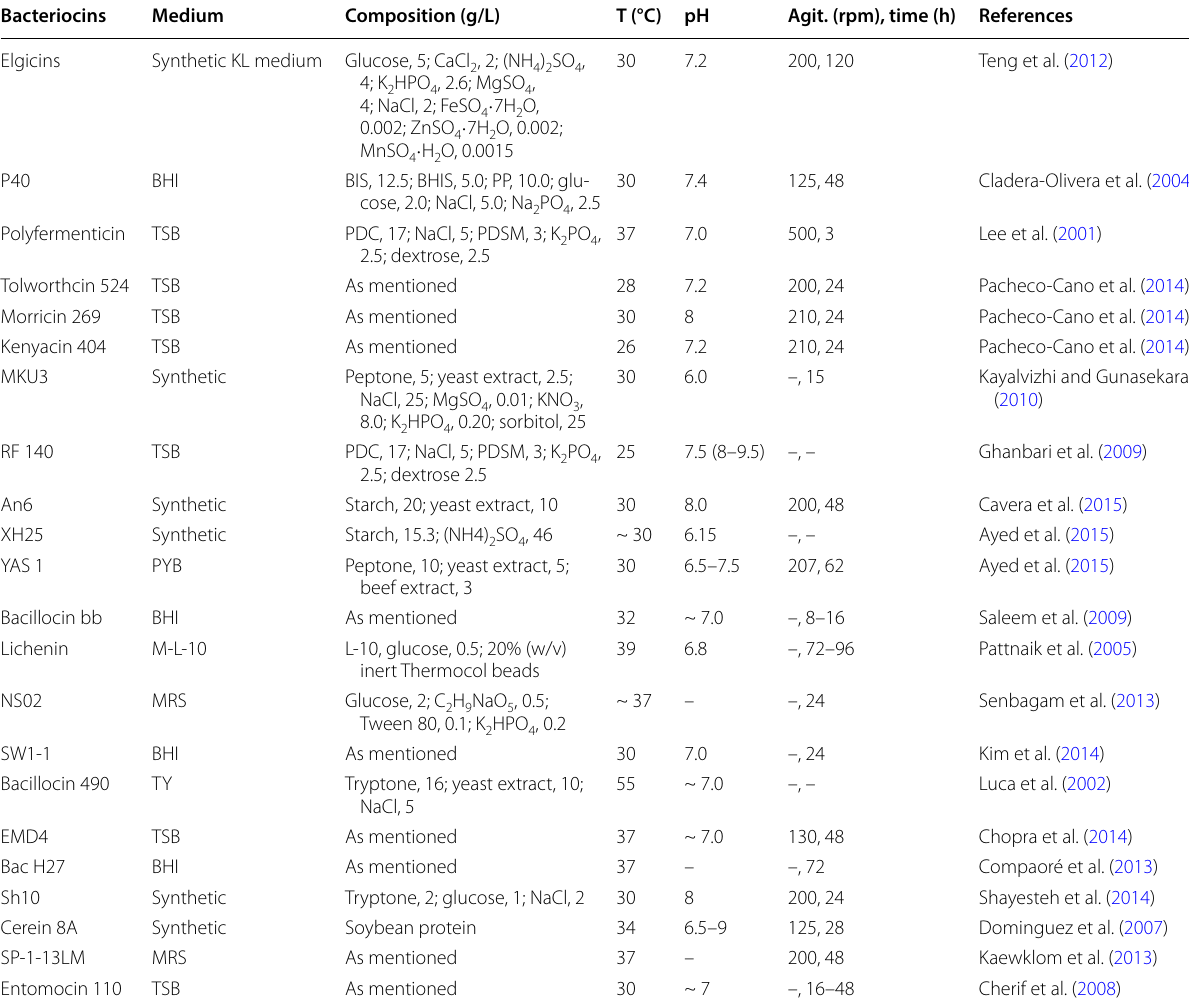
Table 7 Media composition, temperature, pH, agitation speed and fermentation time for the Bacillaceae bacteriocins